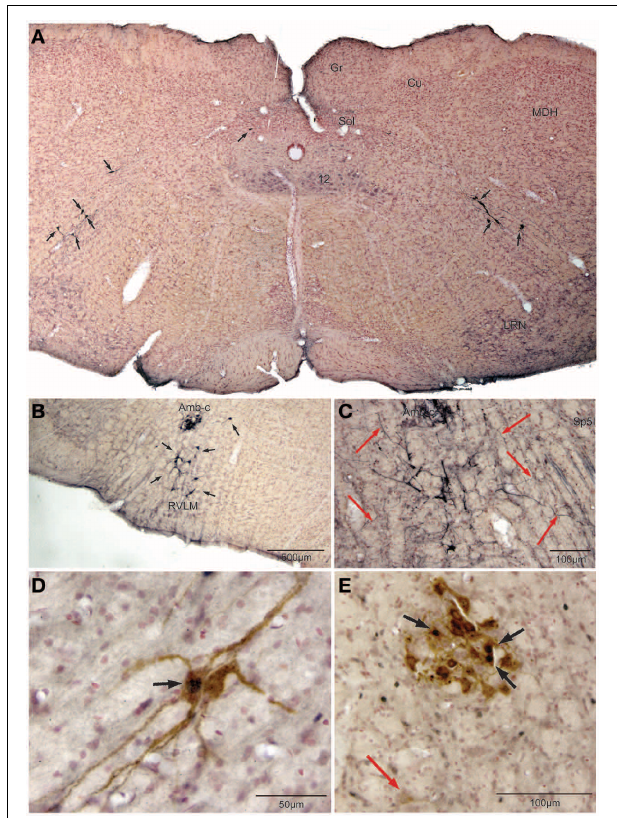
FIGURE 3 | Photomicrographs illustrating retrograde labeling of parasympathetic preganglionic cardiac motor neurons in the medulla of the rat after pericardial injections of cholera toxin B (CTB) and their activation by diving. Photomontage of a medullary section caudal to the obex (A) showing the distribution of caudal preganglionic cardiac motoneurons (arrows) along an oblique line from the ventrolateral part of the dorsal motor nucleus of the vagus nerve toward the nucleus ambiguus. Such distribution is similar to that described in other mammals. Most neurons rostral to the obex (B,C,E) were retrogradely-labeled adjacent or ventral to the compact formation of nucleus ambiguus (Amb-c). Note the long dendrites of neurons ventral to Amb-c ( C , red arrows) extending into the reticular formation, many surrounding Amb-c or approaching the spinal trigeminal nucleus, pars interpolaris (Sp5I). Double labeling of preganglionic cardiac motor neurons after underwater submersion with both cFos (black immunolabeled nuclei) and retrograde transport of CTB (brown cytoplasmic labeling) is shown in (D,E) . Two retrogradely-labeled neurons in the caudal medulla are seen in (D) , one of which was activated by underwater submersion (arrow); note the long obliquely orientation of the dendrites. While some Amb-c neurons were retrogradely-labeled (E) after pericardial injections, neurons labeled with cFos were found on its periphery, some of which were double-labeled (black arrows). A single retrogradely labeled neuron also is shown more ventrally (red arrow).